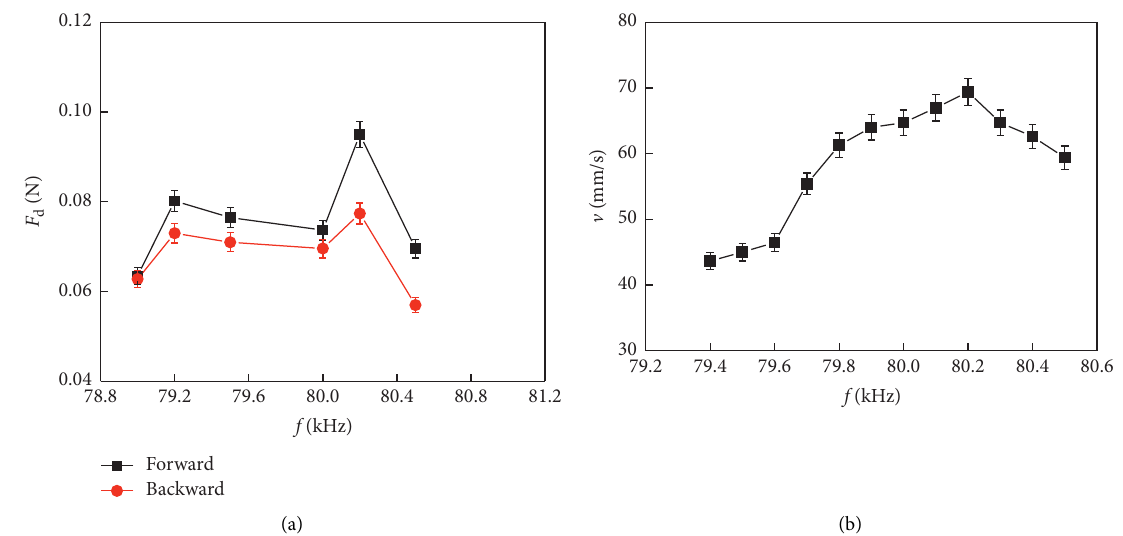
Figure 16: Variation of stall force and average velocity with driving frequencies. (a) Stall force-driving frequency. (b) Average velocity- driving